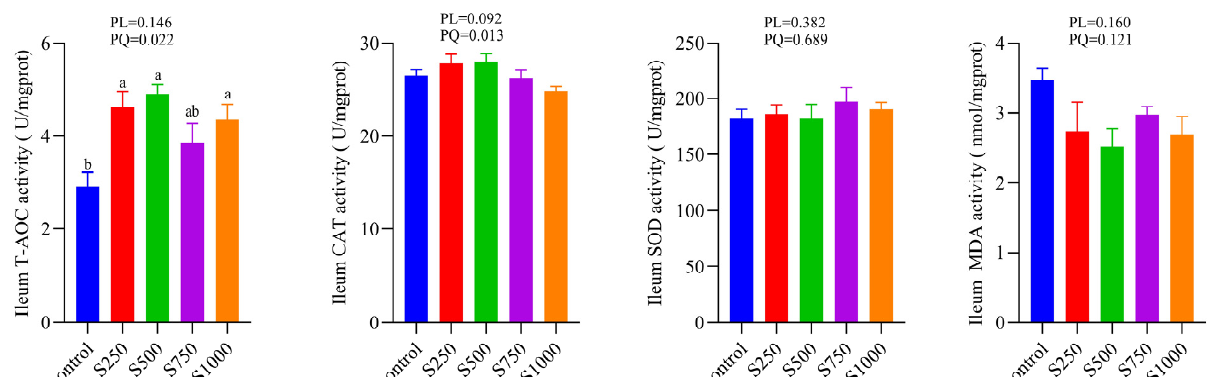
Figure 1. Effects of dietary CSB treatment on antioxidase changes in jejunum and ileum ( n = 6). a,b Means with different superscripts within a column differ significantly ( p < 0.05). T-AOC: total anti- oxidant capacity; CAT: catalase; SOD: superoxide dismutase; MDA: malondialdehyde.